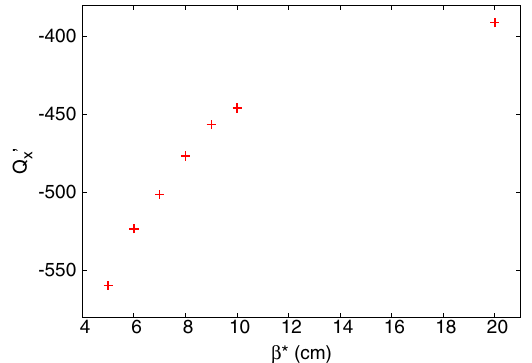
FIG. 6. Natural chromaticity plotted as a function of β (cid:1) with L (cid:1) fixed at 10 m.